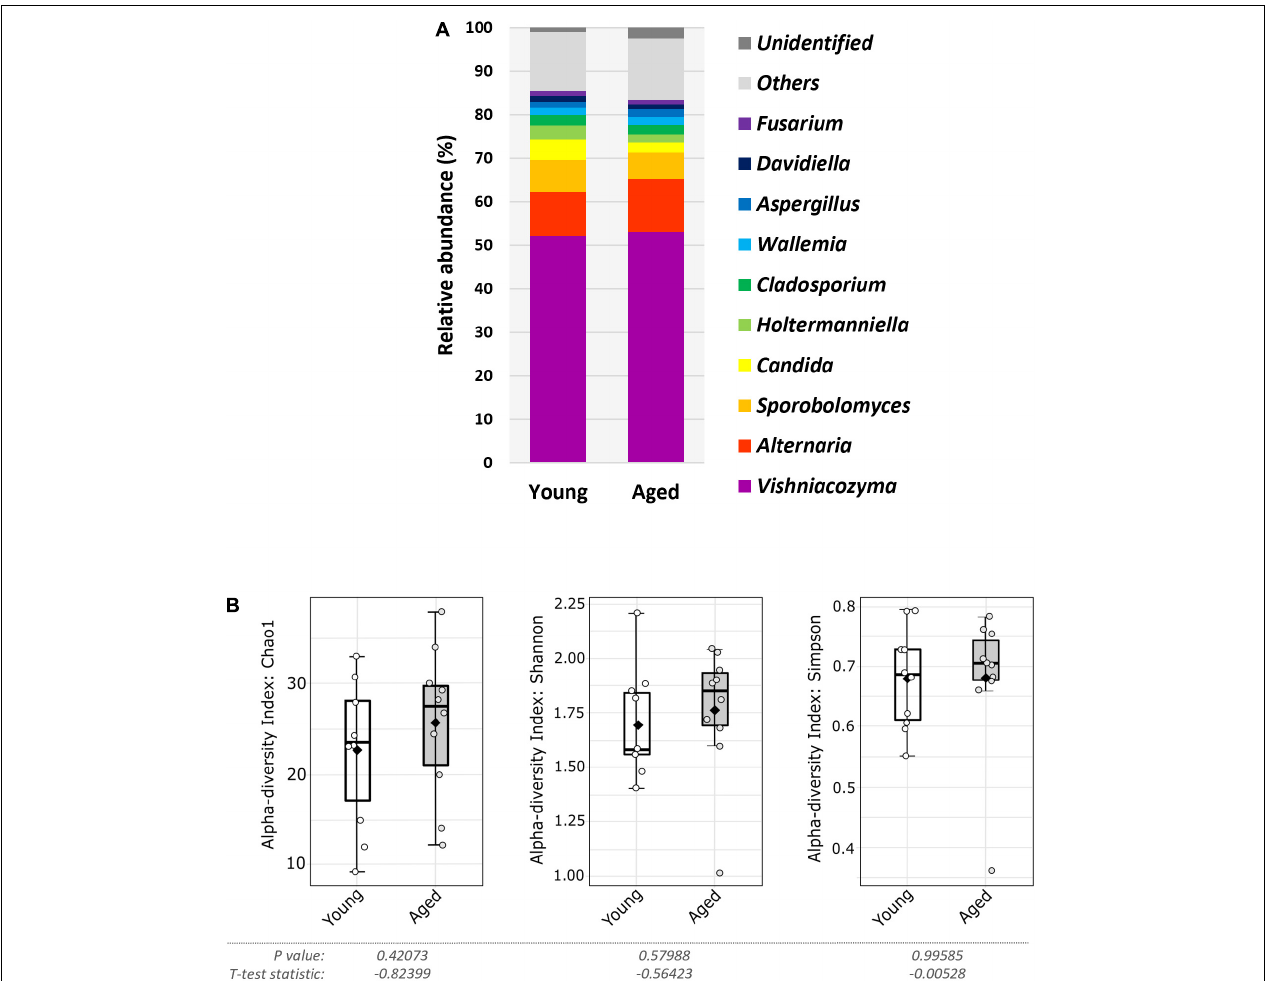
FIGURE 4 | Faecal fungal diversity and top ten genera in aged vs. young SPF mice. (A) Top ten most abundant genera (percentage mean relative abundance) in faecal samples of young vs. aged SPF mice ( n = 10/group). (B) Alpha diversity (L-R: Chao1, Shannon, and Simpson indices) of faecal fungal composition of young vs. aged SPF mice ( n = 10/group), whiskers show spread of data across all mice, solid black dot indicates the mean, horizontal line indicates the